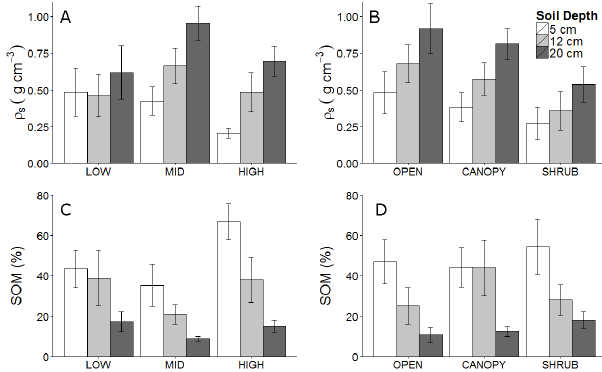
Figure 4. (a, c) Means of soil bulk density (gcm − 3 ) and soil or- ganic matter (%) by elevation treatment. (b, d) Means of soil bulk density (gcm − 3 ) and soil organic matter (%) by vegetation treat- ment. Bars indicate standard error. Colors indicate soil depth pro- files.